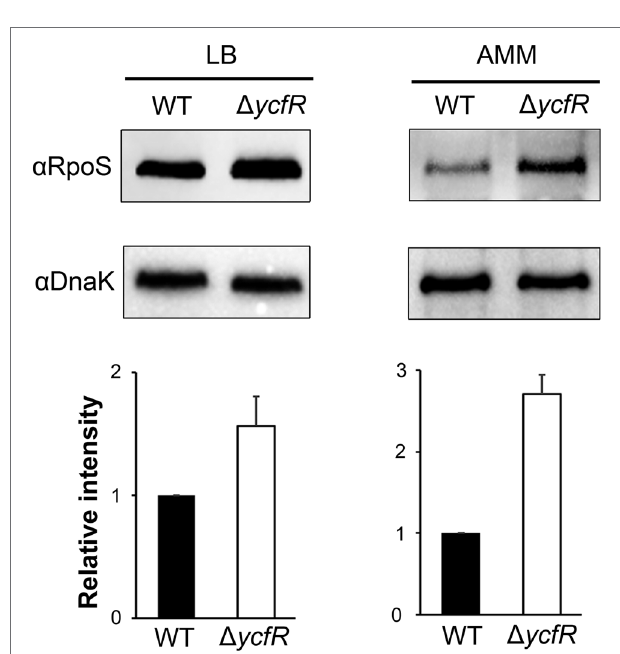
FIGURE 3 | Expression of RpoS in Δ ycfR mutant. Salmonella wild-type and Δ ycfR mutant strains were cultivated in LB medium broth for 10 h or acidic minimal medium (AMM) broth for 3 h, and the expression of RpoS was compared using immunoblot assay with anti-RpoS antibody. The cytosolic protein DnaK was used as a control to standardize the protein amounts between the lanes. The abundance of RpoS was normalized to that of DnaK using ImageJ, and the ratios from three independent assays are depicted below the representative blot